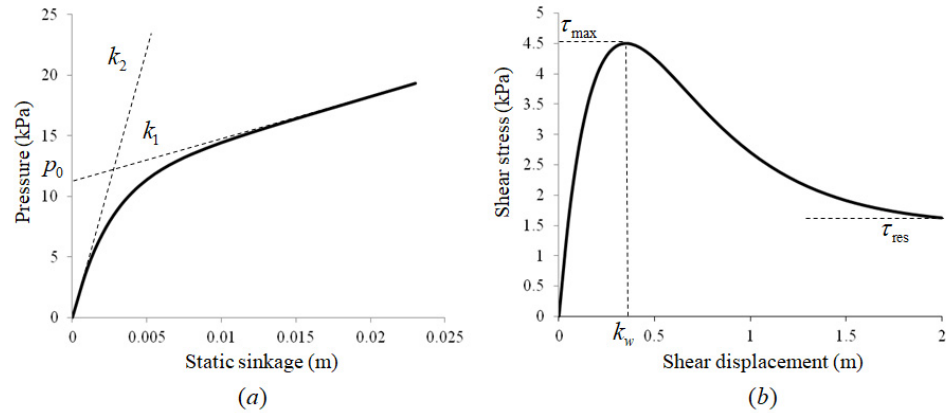
Figure 14. Models for soft soil: ( a ) Bode model for the pressure–sinkage relationship, ( b ) Wong model for shear stress-shear displacement relationship.